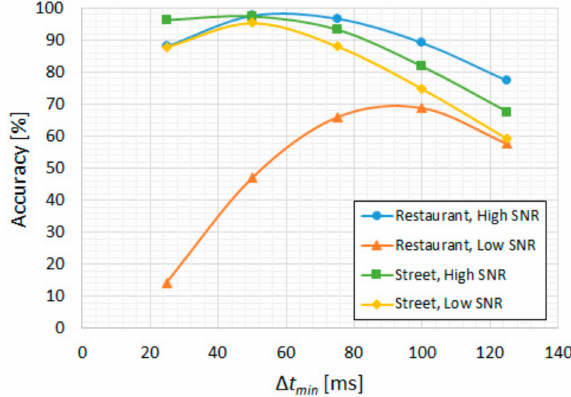
Figure 10. CENSREC-1-C subset B2; CNN-based VAD. “High SNR” groups the 10–20 dB levels and “Low SNR” groups the − 5–5 dB levels: accuracy vs. ∆ t min .